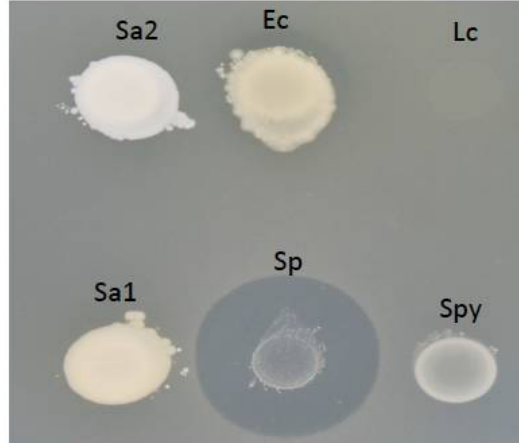
Figure 1. Agar overlay assay testing the ability of various bacterial species to inhibit the growth of a lawn of N. gonorrhoeae strain RL1 ( a ) and strain 21.189 ( b ). Only the colonies of Escherichia coli (Ec) and Streptococcus pneumoniae (Sp) inhibited the growth. The colonies of N. mucosa in ( c , d ) did not exhibit any inhibitory effect on the growth of N. gonorrhoeae strain 21.163 ( c ) and strain WHO-W ( d ). A close-up of one of the N. mucosa colonies in ( d ) demon- strates the pitting ( p ) of the upper layer of agar around the right-hand colony of N. mucosa . Ec — Escherichia coli (ATCC 25922); Lc — Lactobacillus crispatus (LMG 9479); p — pitting; Sa — Staphylococcus aureus (1:ATCC 29213, 2:ATCC 25913); Sp — Streptococcus pneumoniae ( ATCC 49619 ) ; Spy — Streptococcus pyogenes (LMG 14238). Figure 2. A schematic illustration of the difference between growth-inhibition and pitting in the agar overlay assay. An agar plate in cross section is depicted, on which 3 bacterial colonies (labeled ‘in- hibitory’, ‘non-inhibitory’ and ‘pitting’) were spotted and incubated for 24 h before a layer of GCB agar containing 10 6 CFU/mL of N. gonorrhoeae was poured over the plate (grey layer). Whilst the ‘non-inhibitory’ colony had no effect on the growth of N. gonorrhoeae (red line), and the ‘inhibitory’ colony had a clear inhibitory effect, the major effect of the ‘pitting’ colony was to repel the second layer of agar, thus creating an area around it which appears more translucent from above. Close visual inspection, including from the lateral aspect, of the depressed sections of the second layer of agar around the ‘pitting’ colony revealed the uninhibited growth of N. gonorrhoeae .